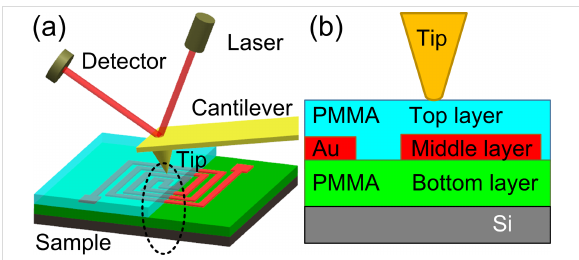
Figure 1: (a) Schematic illustration of CR-AFM imaging on the flexible circuit sample. (b) An enlarged sectional view of the contact between the AFM tip and the multilayer